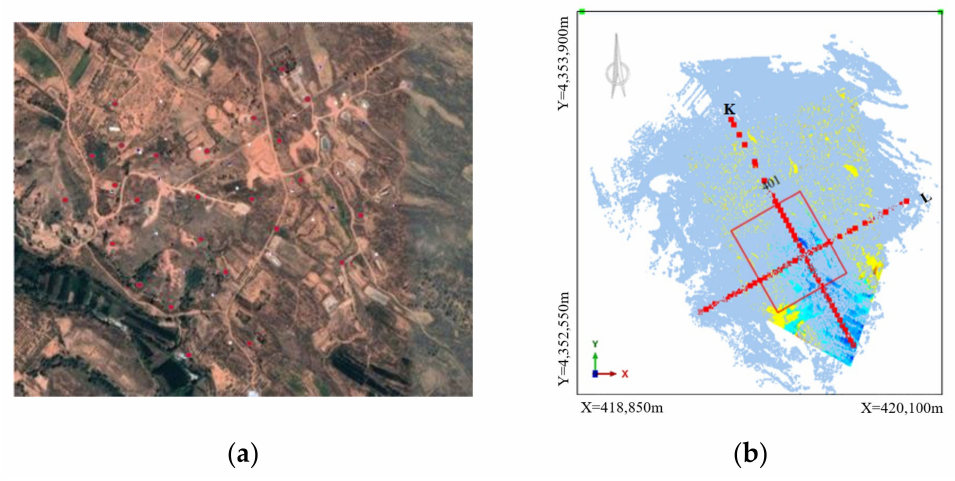
Figure 8. TLS deployment and regional location map: ( a ) TLS distribution; ( b ) Selection area with the point cloud model, working surface relationship map.